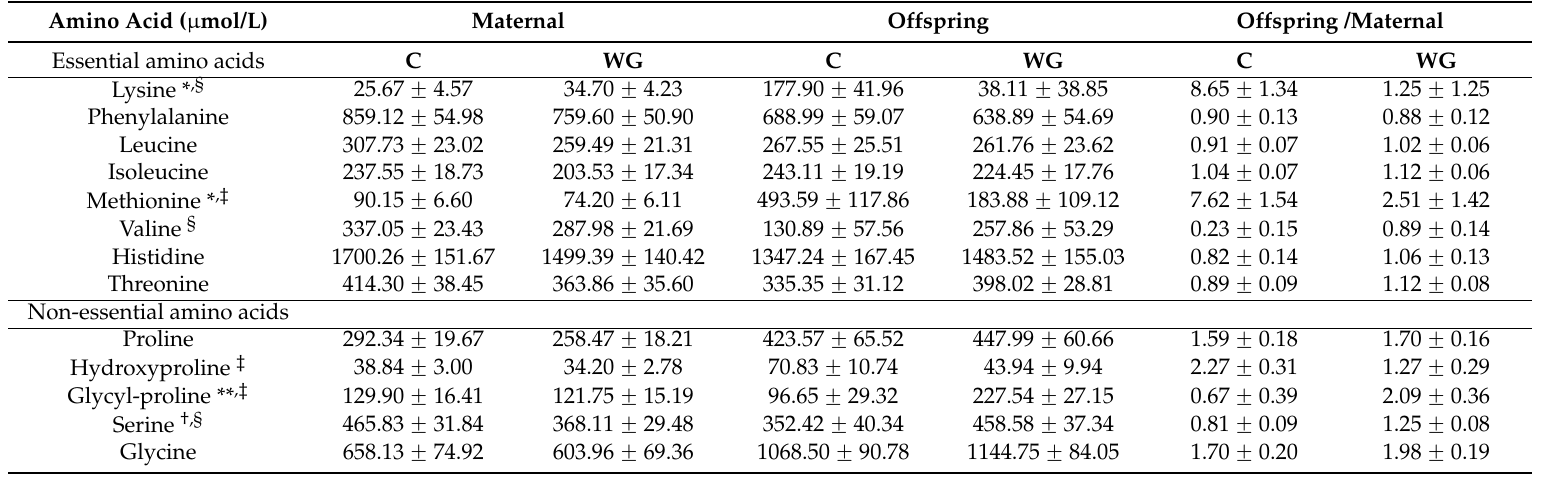
Table 3. Maternal and offspring’s plasma amino acid concentrations at